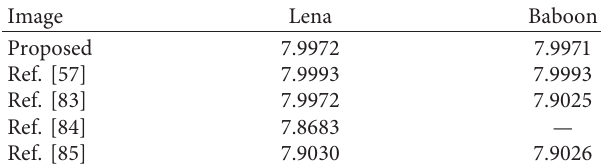
Table 10: Information